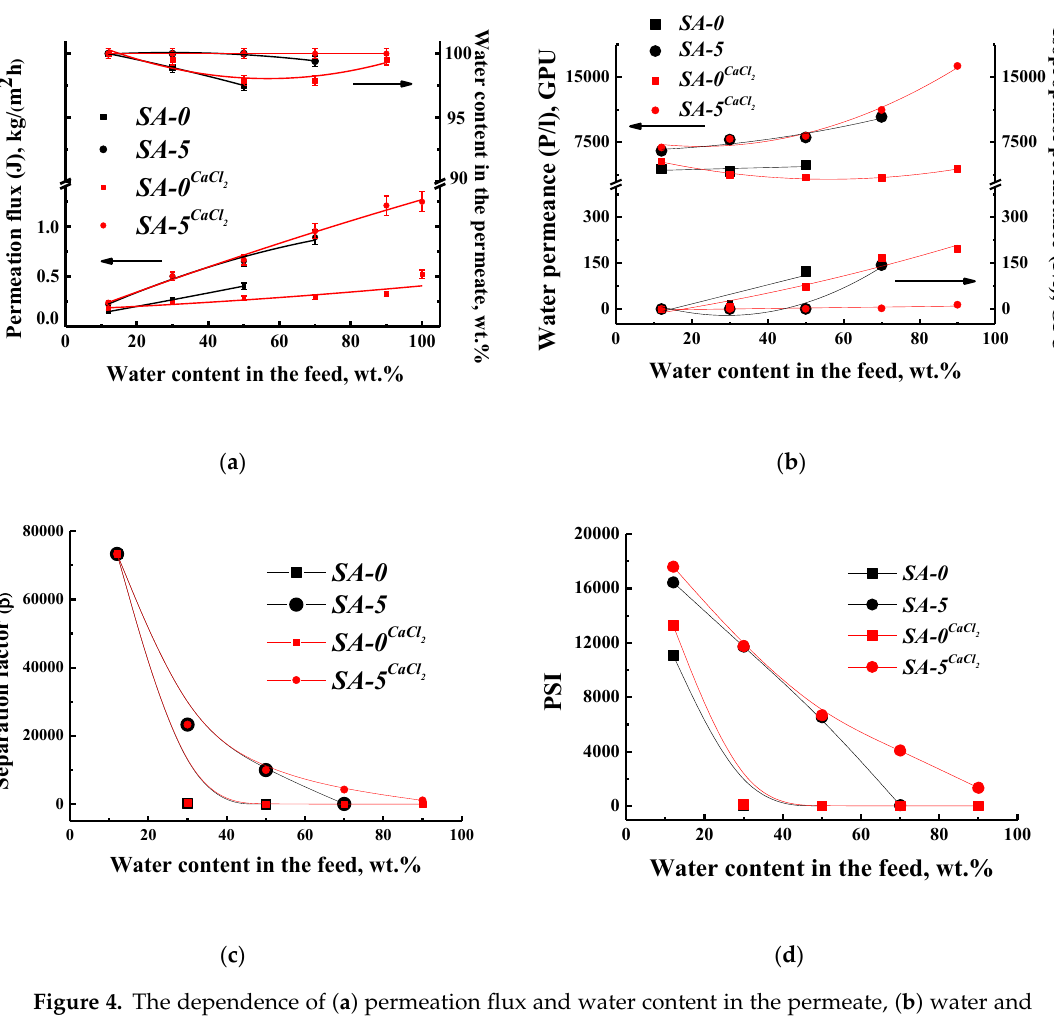
Figure 4. The dependence of ( a ) permeation flux and water content in the permeate, ( b ) water and isopropanol permeances, ( c ) separation factor, and ( d ) pervaporation separation index (PSI) on water content in the feed during pervaporation of the water–isopropanol mixture at 22 °C for untreated and cross-linked SA and SA–fullerenol (5%) membranes.